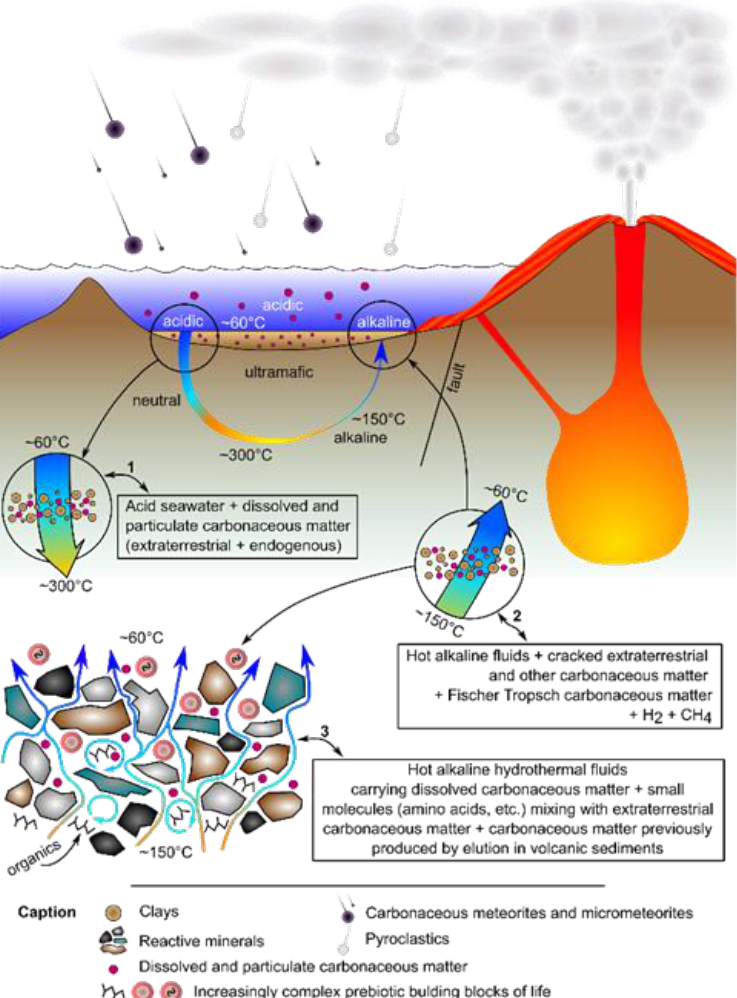
Figure 1. Schematic synthesis of the proposed Hadean, hydrothermal-sedimentary microreactor environment for the complexification of prebiotic chemistry.